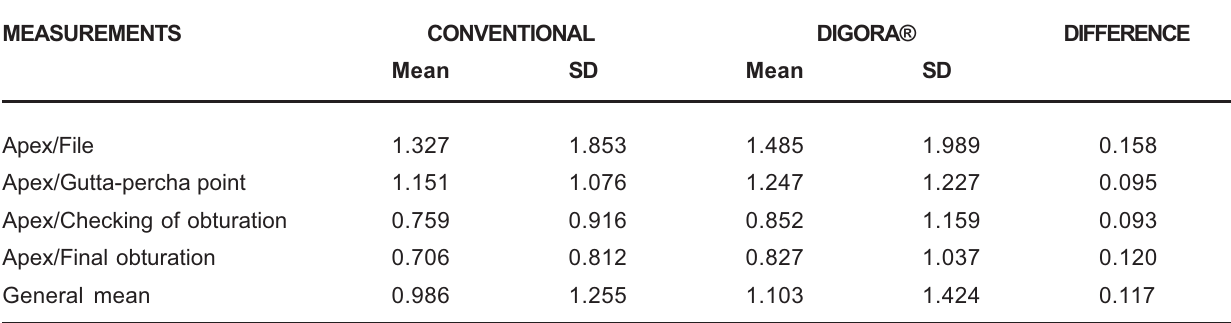
TABLE 1- Means and standard deviations of the measurements (in mm) obtained on the conventional and indirect digitized radiographs